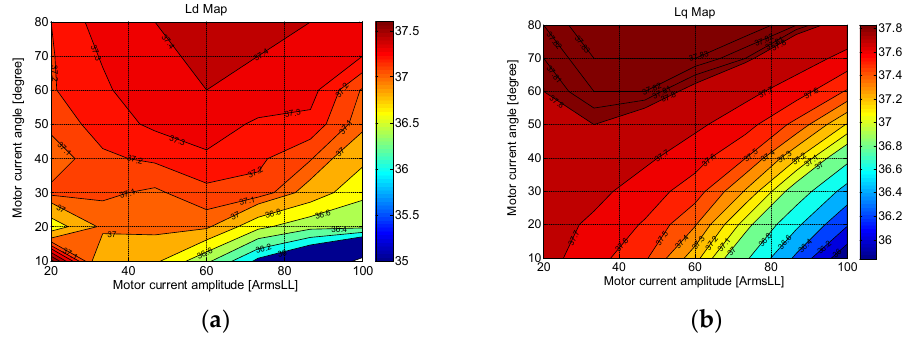
Figure 3. Calculation of the d- and q-axis inductance for a variation in the motor current amplitude and current angle: ( a ) Ld; ( b ) Lq.